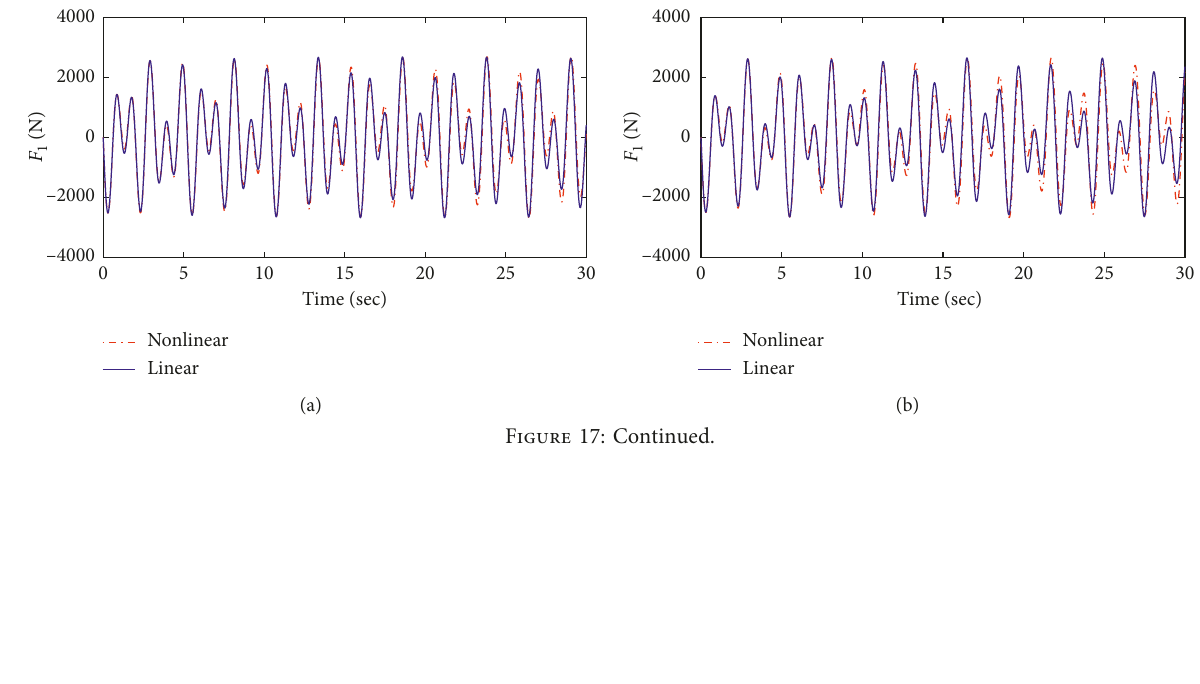
Figure 16: Time history of the surface wave height at the container wall under the lateral harmonic excitation for z (a), 0.4m (b), 0.6m (c), and 0.8 m (d),